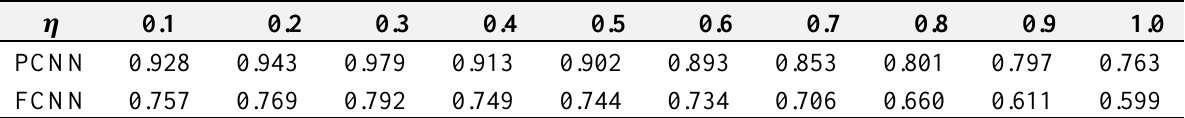
Table 1. Packet transmission success ratio to determine the optimal learning ratio ( η